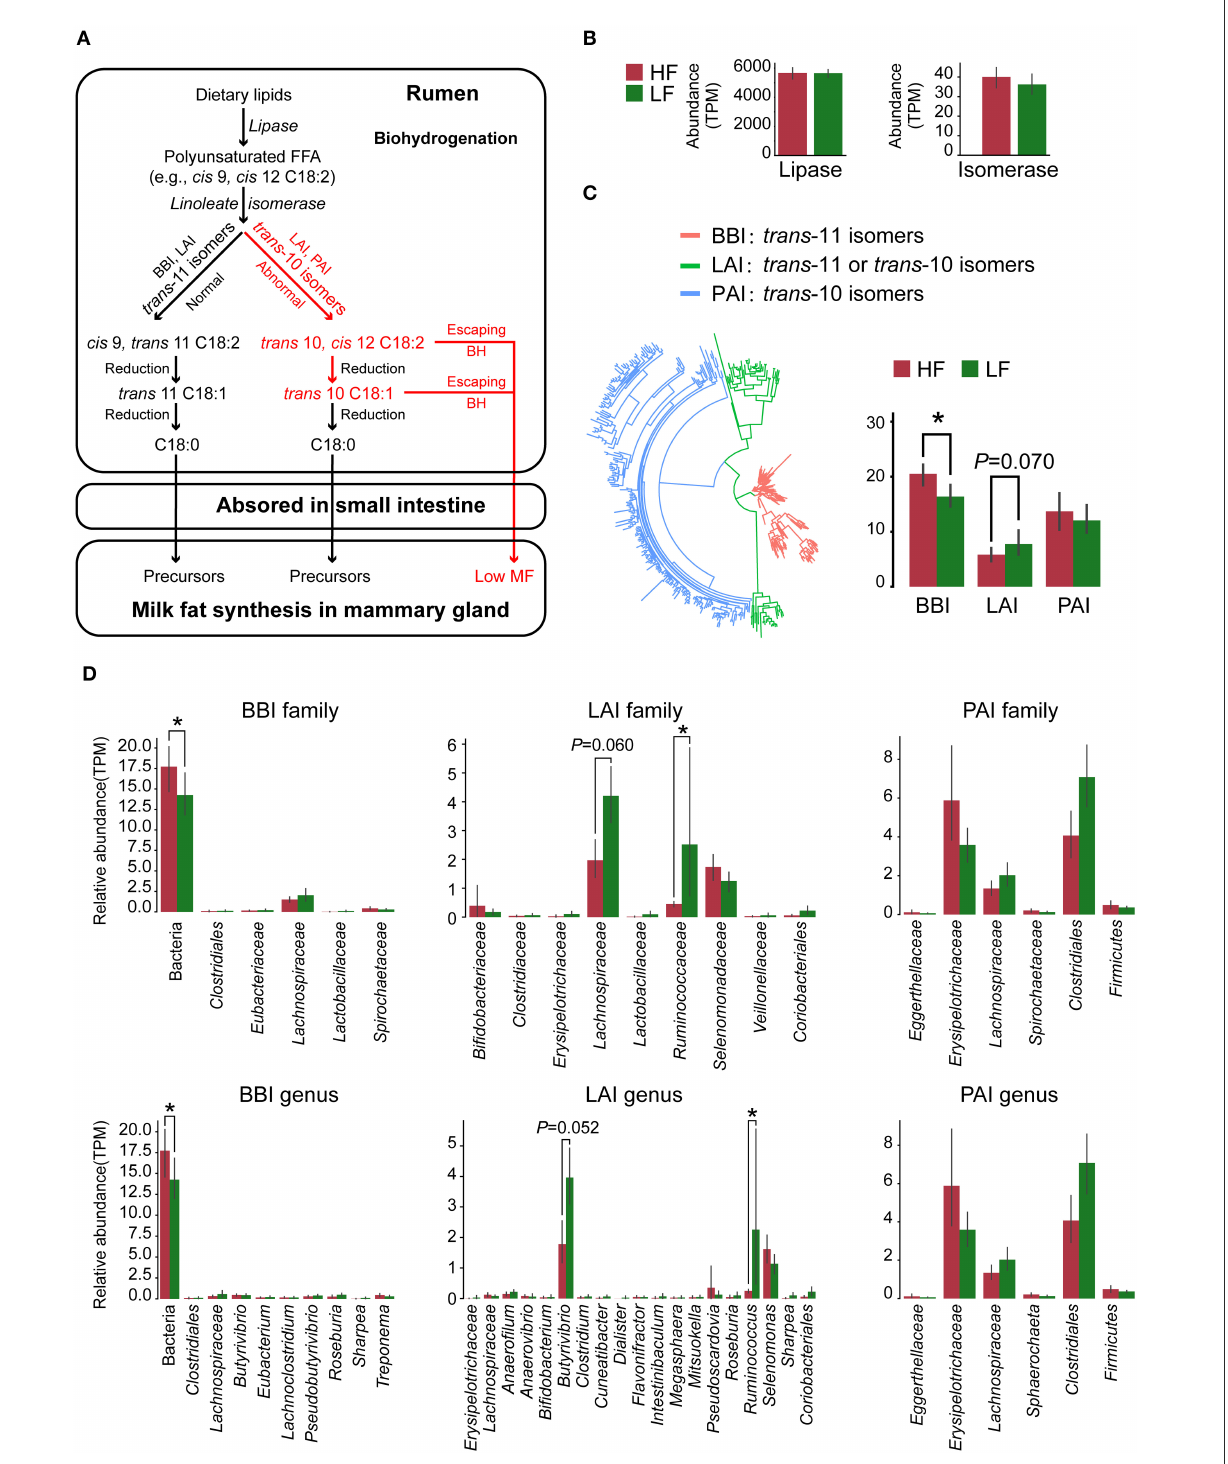
FIGURE3 (A) Major biohydrogenation pathways in the production of C18 fatty acids in the rumen. (B) The relative abundance of lipase and isomerase genes identified in the metagenome data. (C) The classification and relative abundance of three types of isomerase genes identified in the metagenome data. (D) The taxonomic annotation and relative abundance of the isomerase genes. HF, the top 10 cows with the highest milk fat percentage; LF, the last 10 cows with the lowest milk fat percentage; BBI, Bifidobacterium linoleic acid (LA) isomerase; LAI, Lactobacillus LA isomerase; PAI Propionibacterium LA isomerase. *indicated that P < 0.05 in Wilcoxon rank-sum